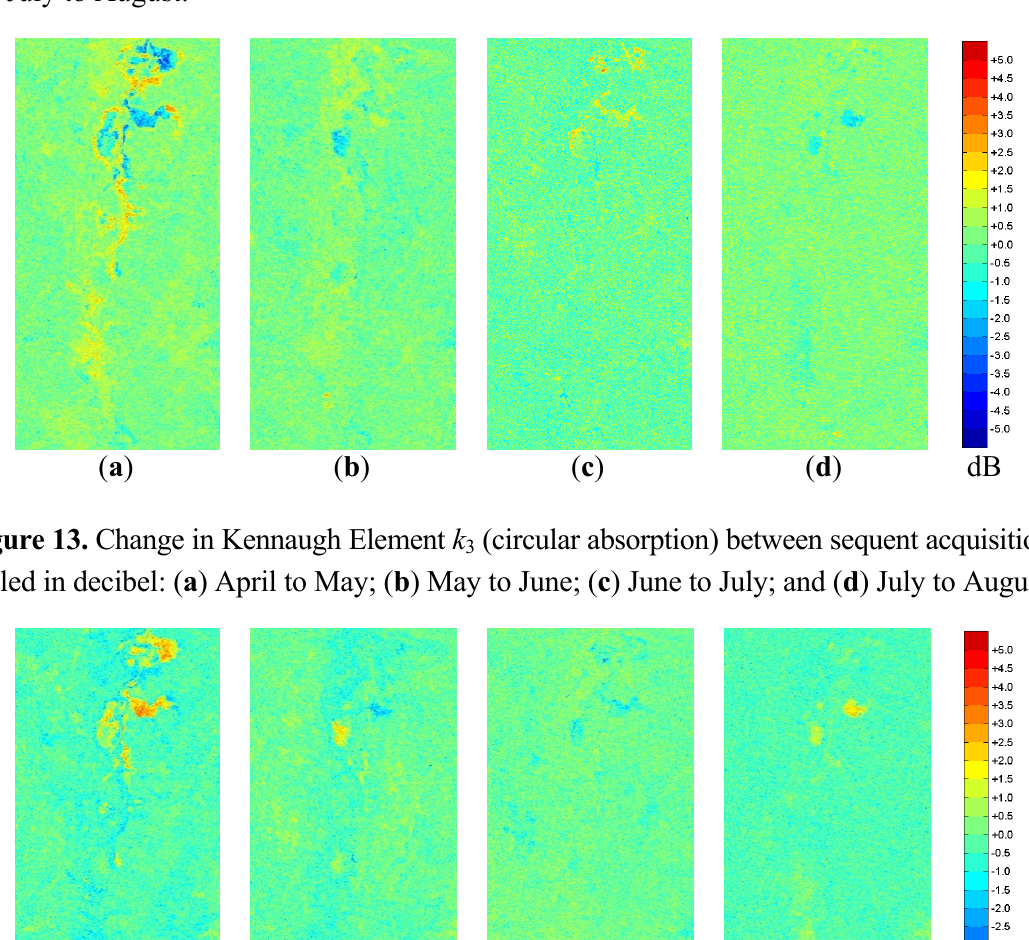
(diagonal absorption) between sequent 2